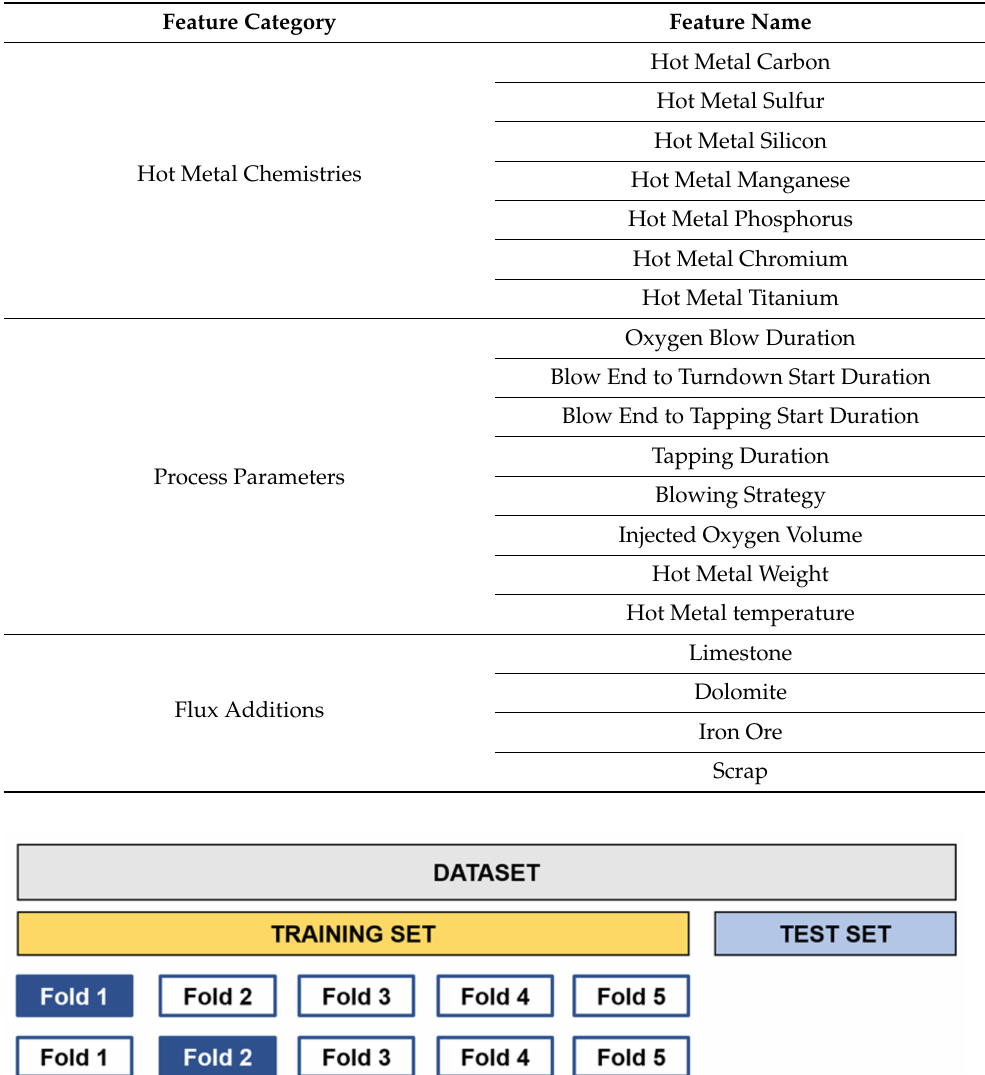
Table 4. Features used for neural network modeling.